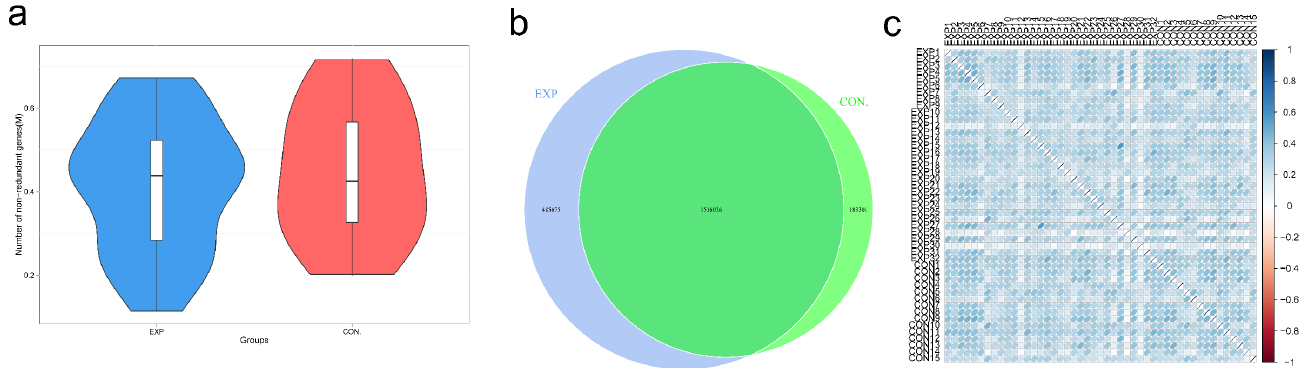
Figure 1. Gene number differences and correlation analysis (BLCA patients, EXP group; healthy individuals, CON group). ( a ) Box plot of gene number between groups. The horizontal coordinate stands for each group, and the vertical coordinate stands for the gene numbers. ( b ) Venn graph. Each circle represents a group. The number in overlapping circles represents the gene numbers shared between groups; the number in non-overlapping circles represents the number of genes unique to the group. ( c ) Sample correlation coefficient heat map. Different colors represent the level of Spearman correlation coefficient. The leftward bias of the ellipse indicates that the correlation coefficient is positive, and the rightward bias is negative.